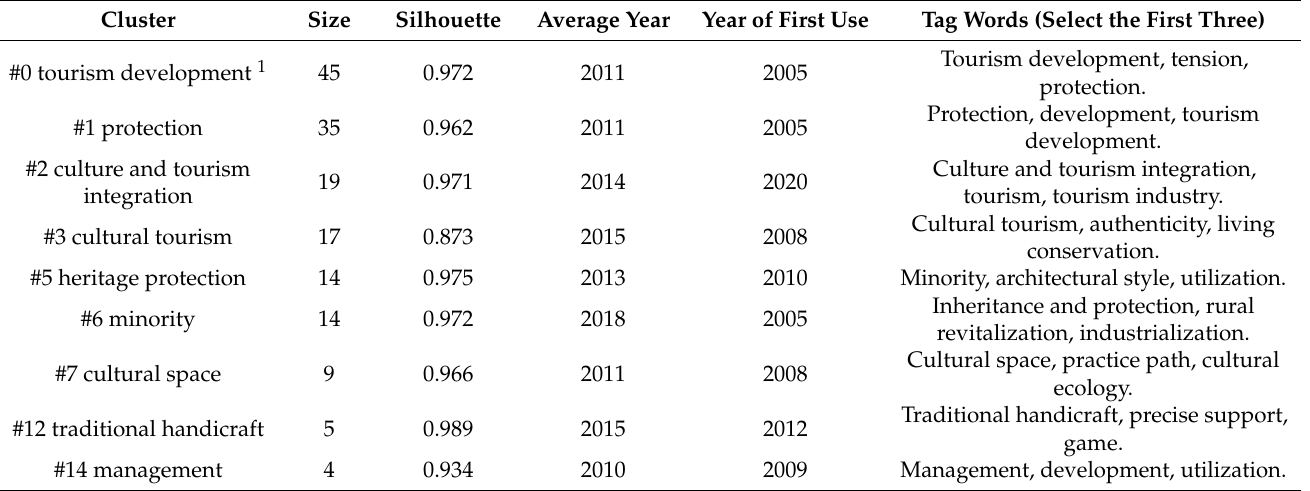
Figure 5. Timeline view of keywords in Chinese journals. Table 3. List of clustering results in Chinese